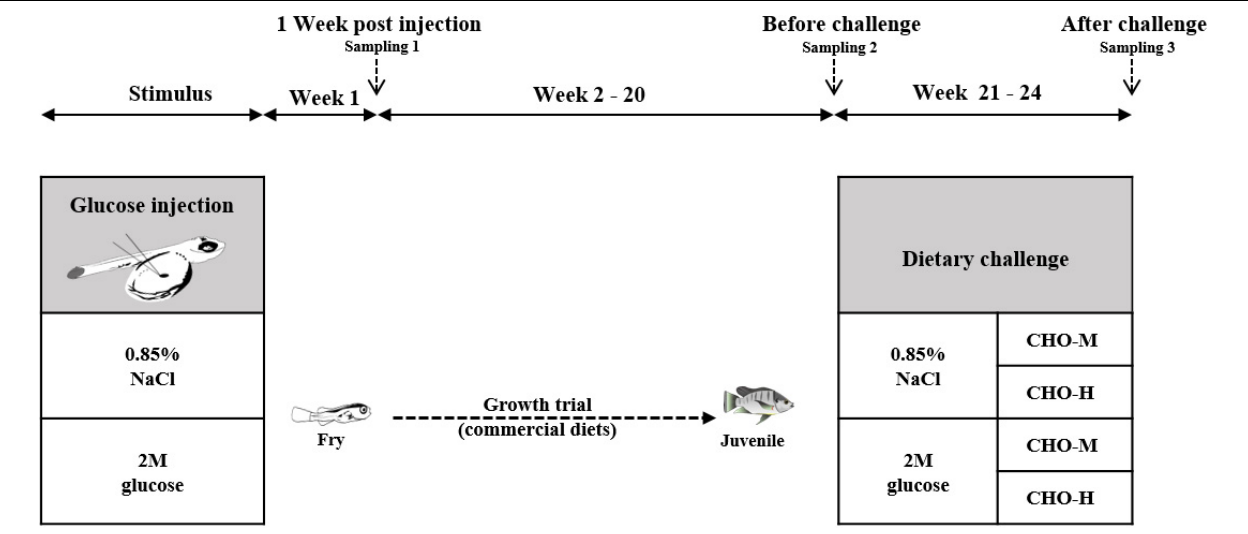
FIGURE 1 | Experimental plan of glucose stimulus by injection (history) and dietary carbohydrate challenge test. Nile tilapia alevins were injected with either a saline (0.85% NaCl) or a glucose (2 M) solution into the yolk sac at the newly hatching stage. At 1 week post injection (wpi), larvae were sampled to determine the body glucose and glycogen contents and the expression of genes that are involved in carbohydrate metabolism. See Table 1 for the list of genes and their respective primers. Subsequently, the fish were cultured for a growth trial during 2–20 wpi. During the growth trial, commercial diets (during 2–8 wpi: 40% CP + 8% CF; during 9–20 wpi: 32% CP + 4% CF) were used. During 20–24 wpi, the fish were subjected to a challenge test with different dietary carbohydrate levels (37% carbohydrates, CHO-M; 67% carbohydrates, CHO-H). Fish sampling was carried out before (20 wpi) and after (24 wpi) the challenge test.